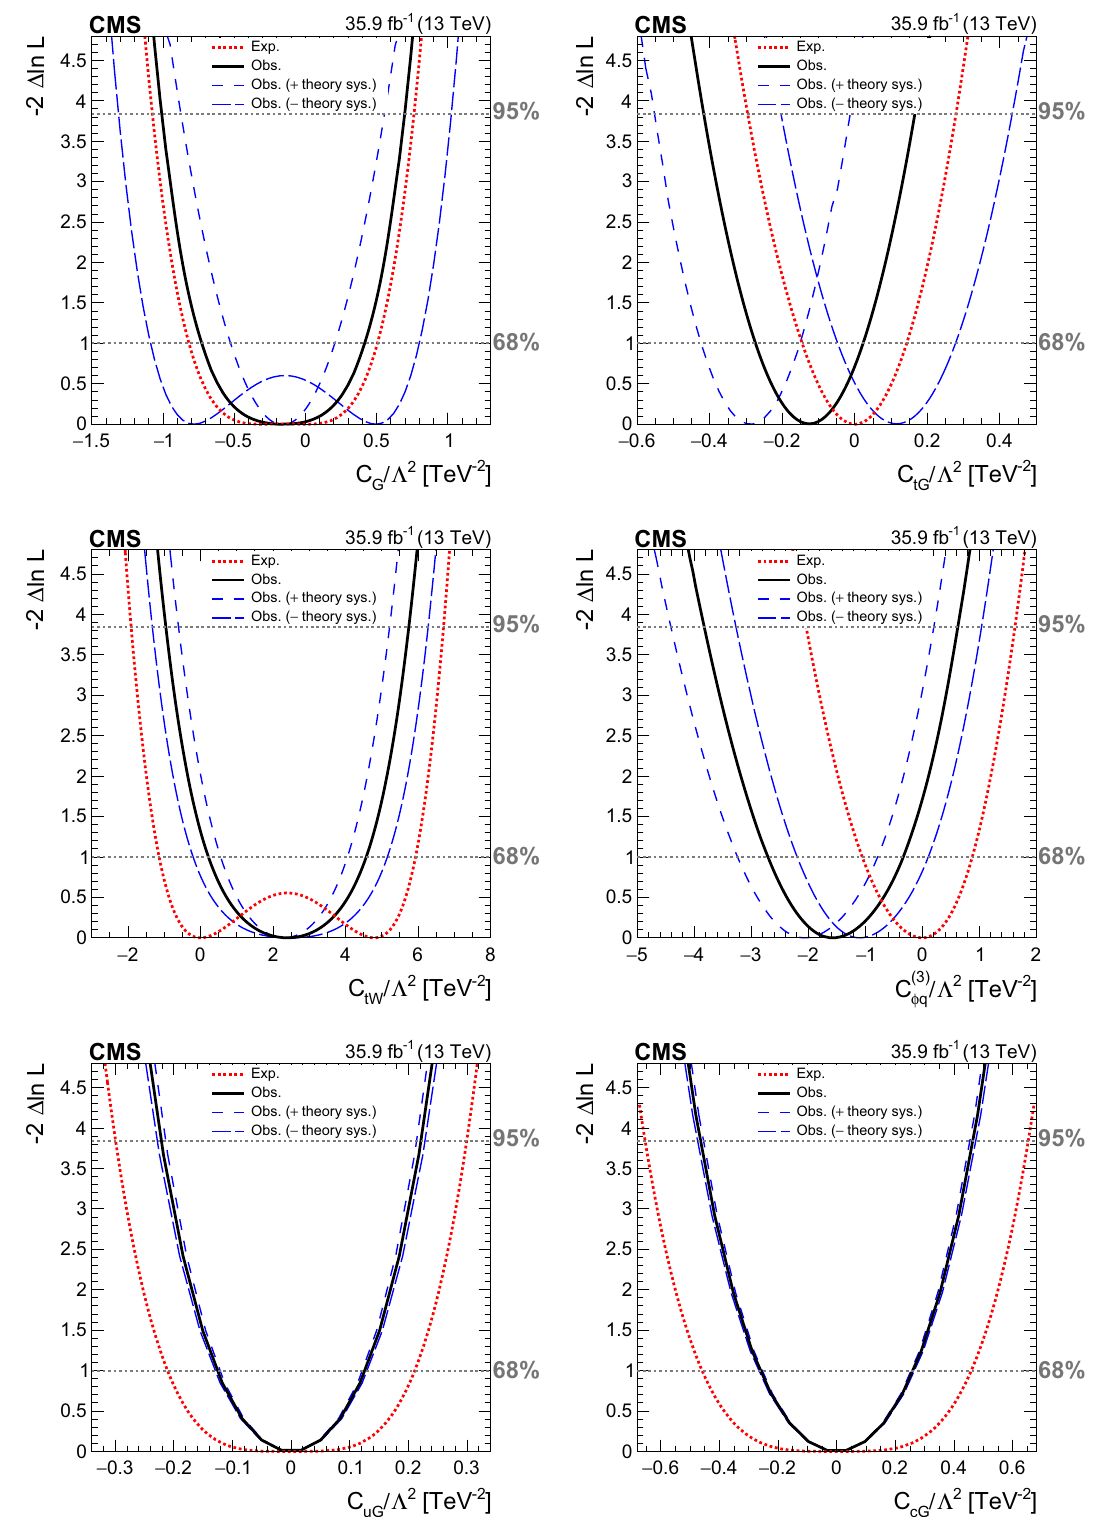
Fig. 5 Observed (solid) and expected (dotted) log likelihoods for the effective couplings: C G (upper left), C tG (upper right), C tW (middle left), C φ q (middle right), C uG (lower left), and C cG (lower right). The